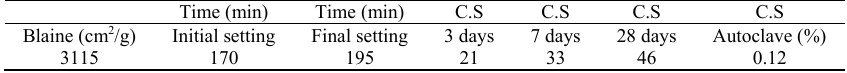
Table 2: Analysis of the physical properties of cement.